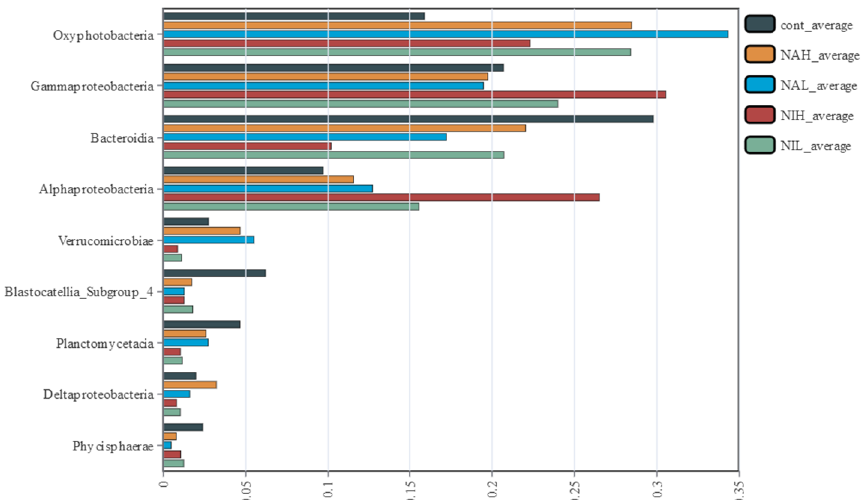
Figure 3. Changes in the relative abundance of the dominant species at class level from different treatments (n = 3). Significant differences between all the treatments were determined by Kruskal– Wallis (KW) sum-rank test and then corrected for multiple test according to the Benjamini–Hochberg false discovery rate (FDR) procedure, with p < 0.05. Cont: control; NAH: 1 mg/L sodium selenate); NAL: 100 µg/L sodium selenate; NIH: 1 mg/L sodium selenite; NIL: 100 µg/L sodium selenite.